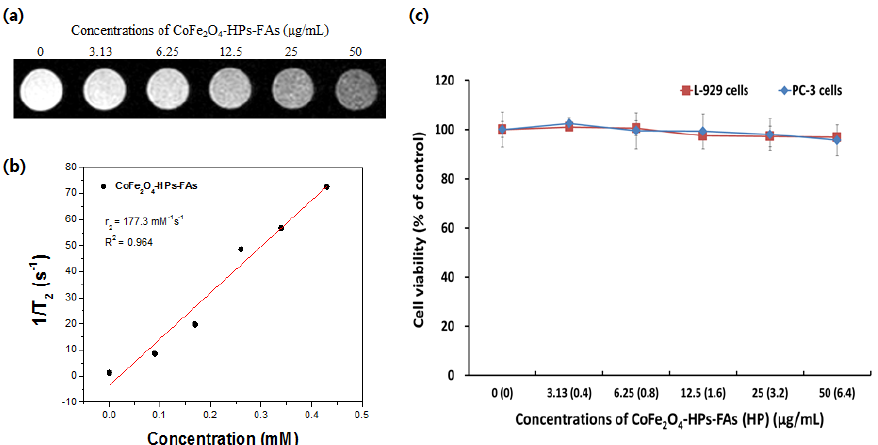
Figure 4. T 2 ‐ weighted MR imaging and biocompatibility of CoFe 2 O 4 ‐ HPs ‐ FAs. ( a ) T 2 ‐ weighted MR Figure 4. T 2 -weighted MR imaging and biocompatibility of CoFe 2 O 4 -HPs-FAs. ( a ) T 2 -weighted MR images of prostate cancer cells (PC ‐ 3 cells) treated with CoFe 2 O 4 ‐ HPs ‐ Fas; ( b ) Plot of T 2 relaxation images of prostate cancer cells (PC-3 cells) treated with CoFe 2 O 4 -HPs-Fas; ( b ) Plot of T 2 relaxation rate r 2 (1/T 2 ) for CoFe 2 O 4 -HPs-Fas; ( c ) Cytotoxicity of CoFe 2 O 4 -HPs-FAs (60 nm) in fibroblasts (L-929